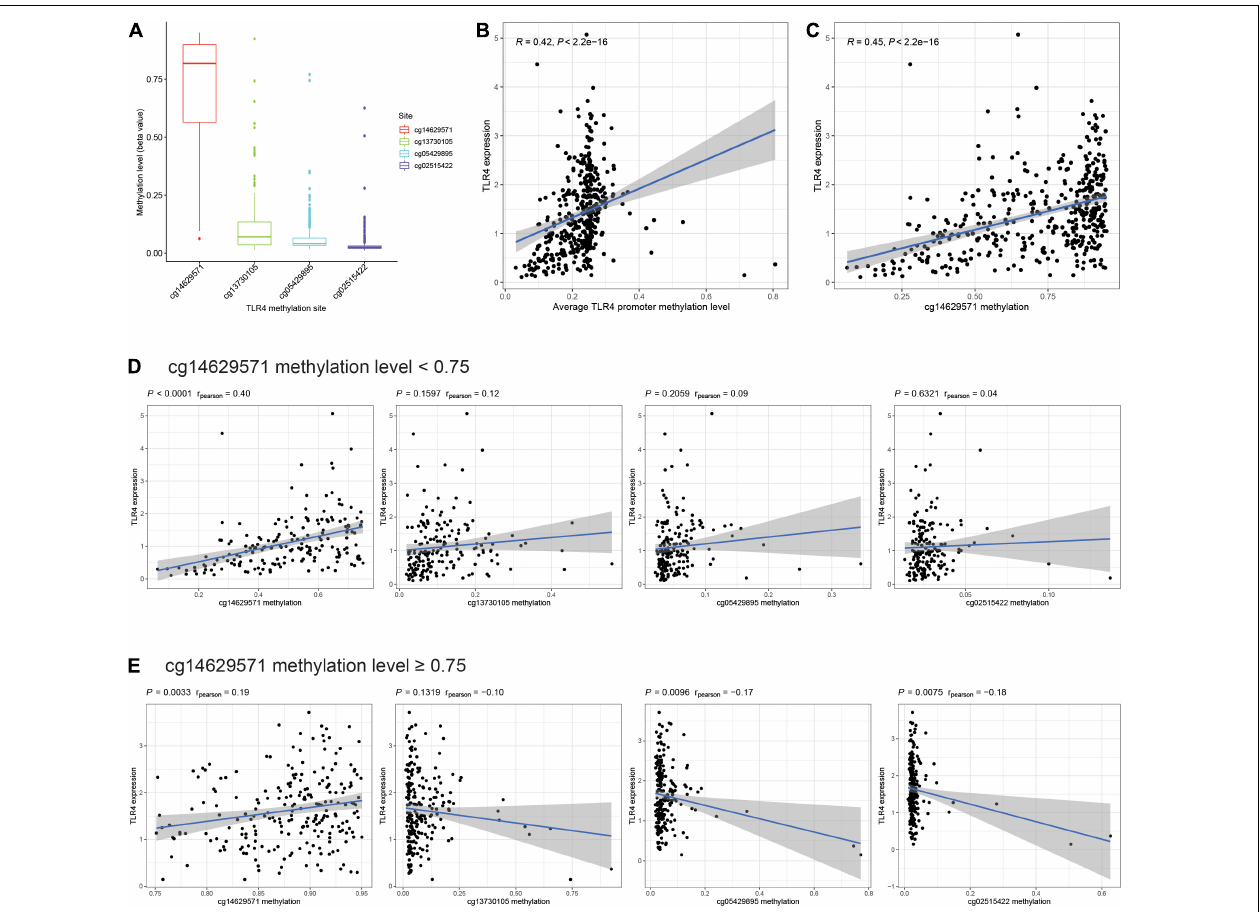
FIGURE 3 | Comprehensive analysis of TLR4 promoter methylation sites. (A) The methylation levels (beta value) of four promoter methylation sites of TLR4 in TCGA. (B) Correlation between TLR4 expression and the average TLR4 promoter methylation level. (C) Correlation between TLR4 expression and the methylation level of cg14629571. (D) Correlation between TLR4 expression and the methylation levels of each site in patients with a cg14629571 methylation level less than 0.75. (E) Correlation between TLR4 expression and the methylation levels of each site in patients with a cg14629571 methylation level greater than or equal to